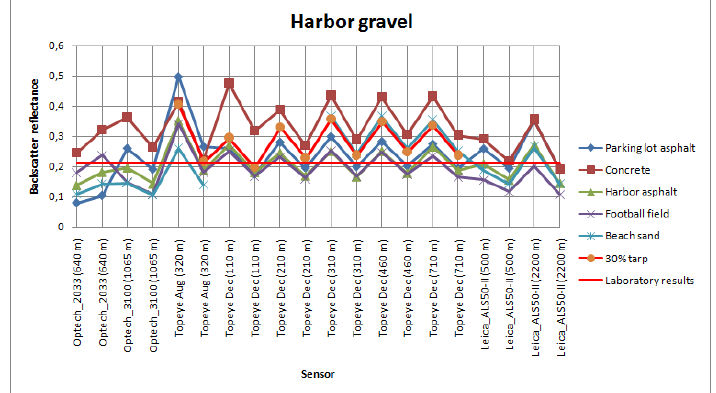
Figure. 7B. Backscatter reflectances of the harbor gravel sample calibrated with different samples as reference.